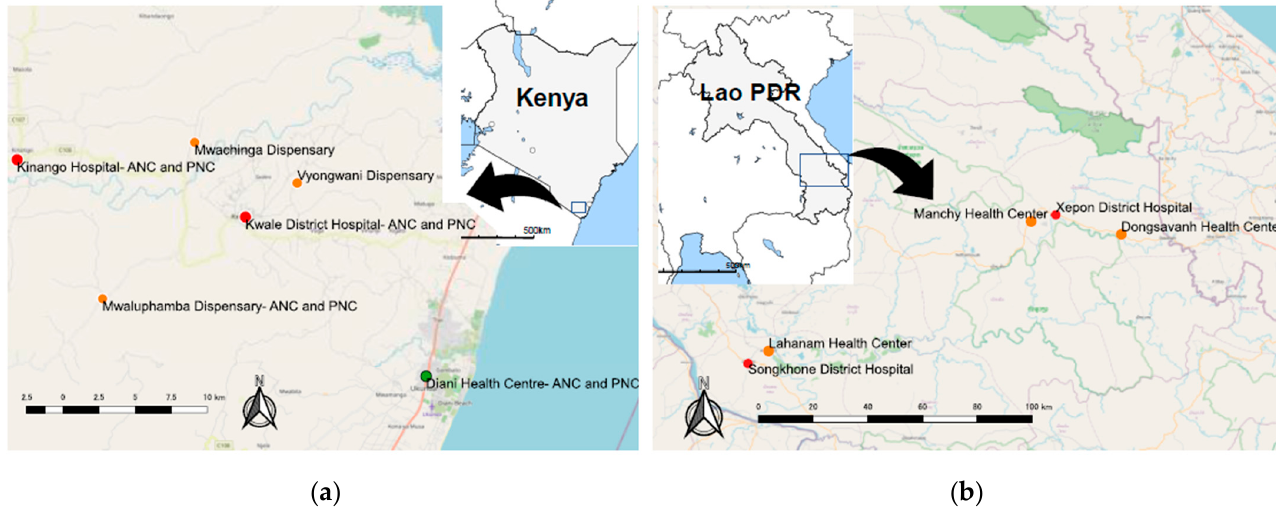
Figure 1. Study sites and health facility locations: ( a ) Kwale county in Kenya: Kwale District Hospital, Kinango Hospital, Diani Health Clinic, Mwaluphamba Dispensary, Mwachinga Dispensary, and Vyongwani Dispensary; ( b ) Savannakhet province in Lao PDR: Songhkone District Hospital, Lahanam Health Center, Xepon District Hospital, Dongsavanh Health Center, Manchy Health Center.